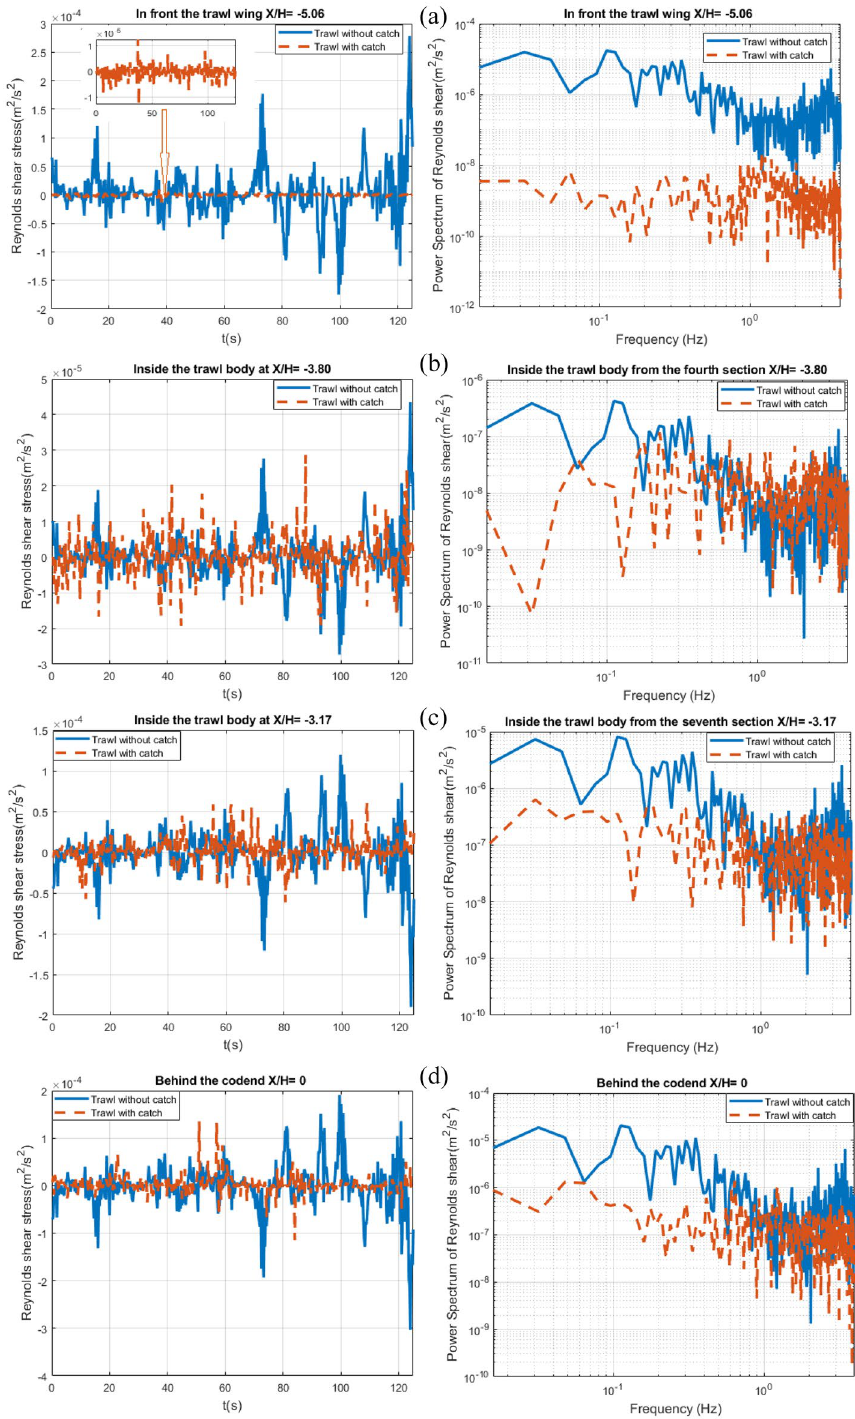
Figure 15. Time evolution of the Reynolds stress shear component u ′ w ′ (right) linked to the normalized frequency spectrum (left in a log–log scale) at ( Y/H = 0 and Z/H = 0.506 ) represented as: ( a ) In front of the trawl wing ( X/H = − 5.06) , ( b ) Inside the fourth section of trawl body ( X/H = − 3.80) , ( c ) Inside the seventh section of trawl body ( X/H = − 3.17) , and ( d ) Behind the codend ( X/H =